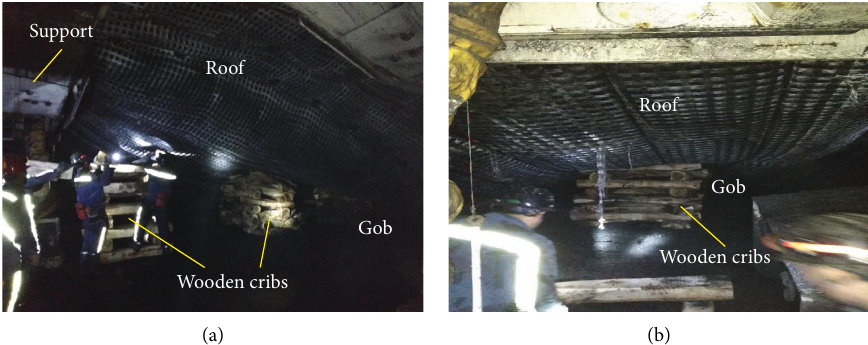
Figure 24: Control effect of the rock surrounding the recovery roadway during the extraction of